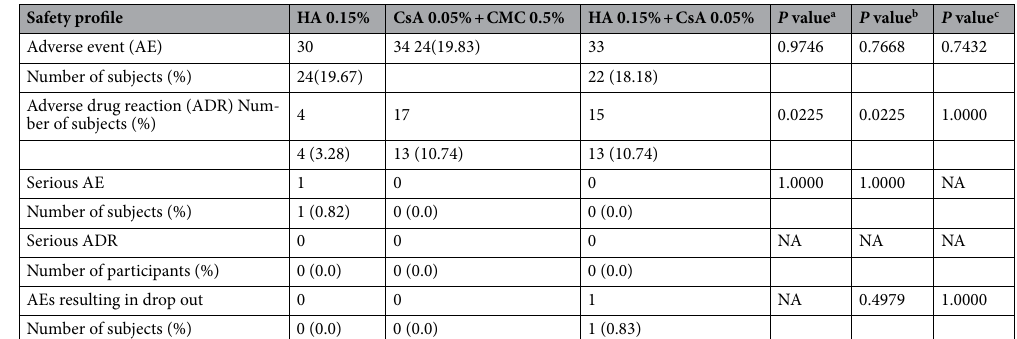
Table 2. Adverse events evaluated in the safety set. HA hyaluronic acid, CsA cyclosporine A, CMC carboxymethylcellulose. a Difference between 0.15% HA and 0.05% CsA + 0.5% CMC group. b Difference between 0.15% HA and 0.15% HA + 0.05% CsA group. c Difference between 0.05% CsA and 0.15% HA + 0.05% CsA group.